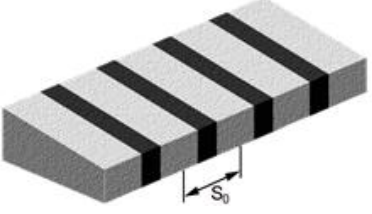
Figure 2. Interlamellar spacing of pearlite. Table 1. Microstructural parameters as a result of the cooling system.